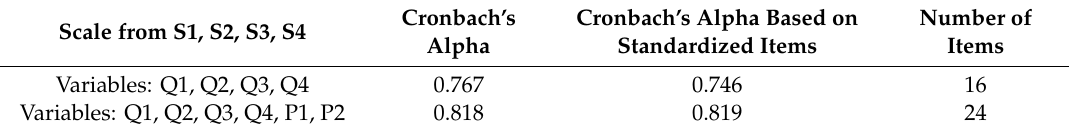
Table 8. Reliability